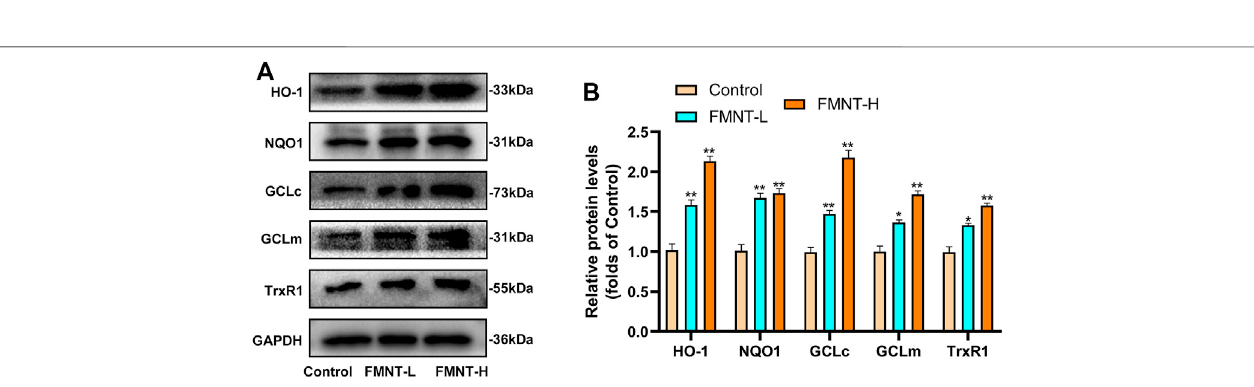
FIGURE6|(A) Theproteinexpression ofHO-1,NQO1, GCLc,GCLm, TrxR1 andKeap1 wasdetected bywesternblot (B) Theexpressing levelsofproteins relate to antioxidant/phase II detoxi fi cation enzymes. All data represent mean ± SD. * p ≤ 0.05 and ** p ≤ 0.01 compared to the control